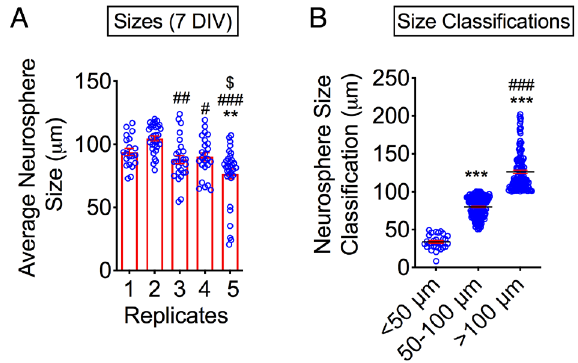
Figure 3. Size classification of primary neurospheres from the dorsal lateral ventricle. ( A ) Average size of primary neurospheres per field of view after 7 days in vitro (N=5). ( B ) The comparison of the numbers of neurosphere that are less than 50 μm, between 50- 100 μm, and greater than 100 μm. Key to statistics **, *** = p <0.01, 0.001, respectively, in comparison to NS less than 50 μm or replicate 1. #, ##, ###, = p < 0.05, 0.01, 0.001, respectively, in comparison to NS between 50-100 μm or replicate 2. $ = p <0.05 in comparison to replicate 3 (minimum of 5 independent samples; N=29, N=214, N=136, respectively to NS<50 μm, NS between 50 μm -100μm, NS>100 μm). between primary neurospheres that were greater than 100 μm compared to neurospheres that were between 50–100 μm (p <0.0001) (Figure 3B). Numbers and sizes of